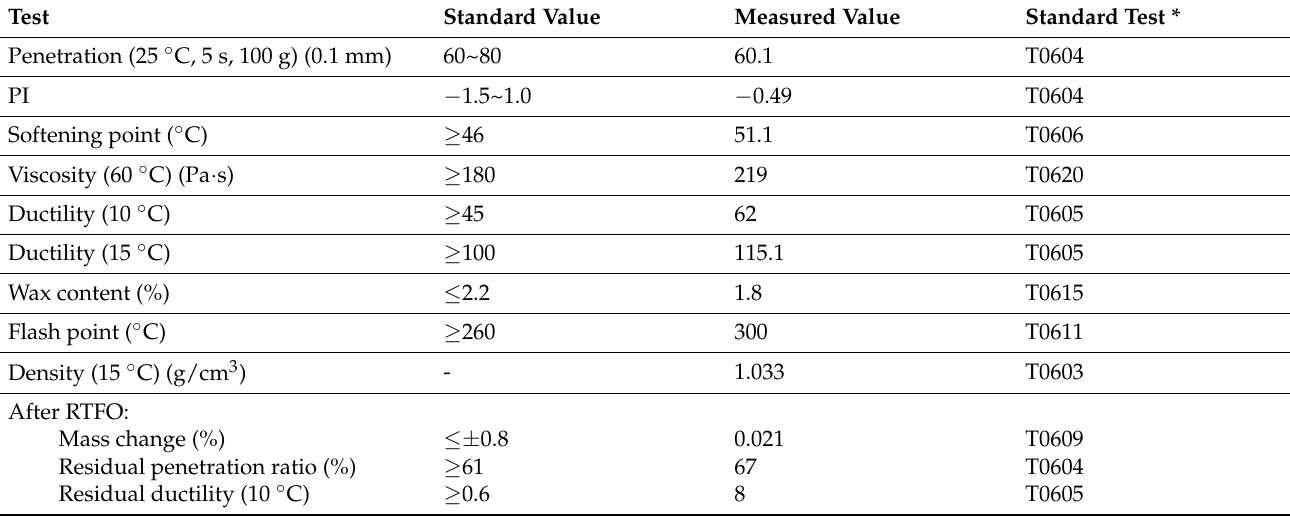
Table 1. Physical properties of 70# neat asphalt